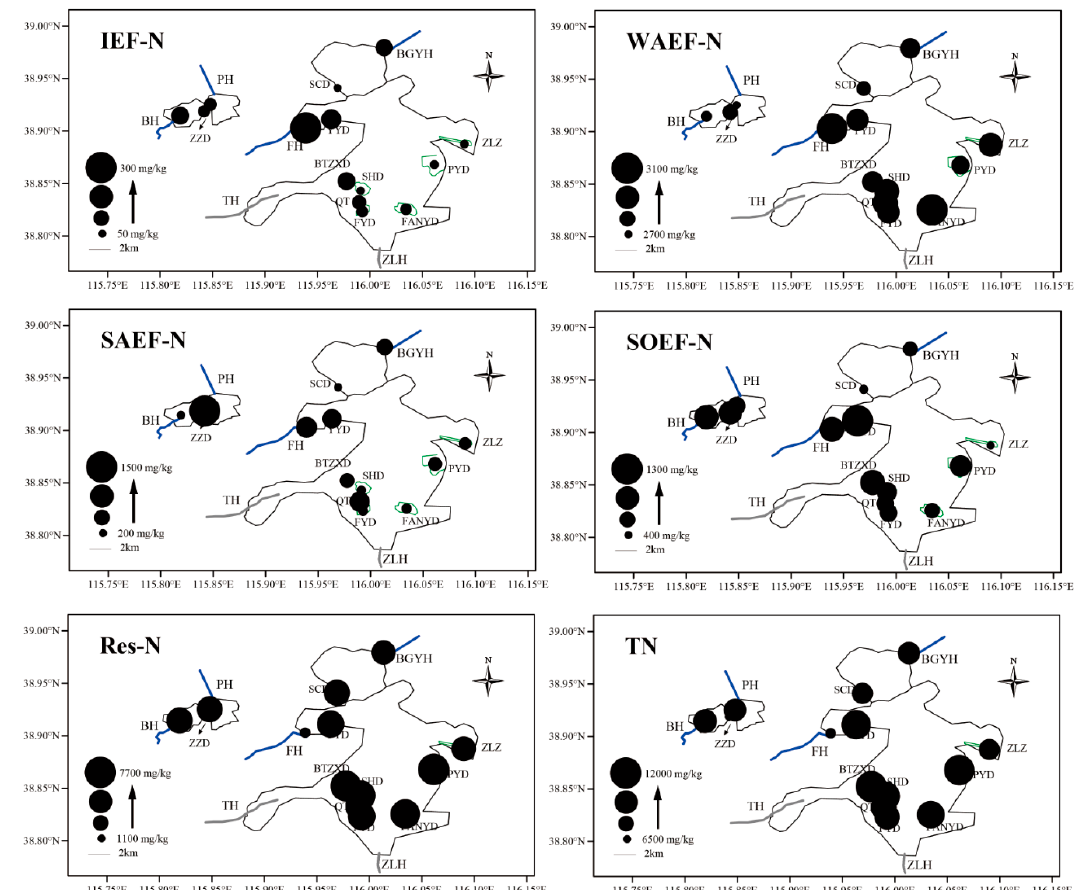
Figure 2. Spatial distribution for IEF-N, WAEF-N, SAEF-N, SOEF-N, Res-N and TN of sediment N in Baiyangdian Lake (the size of circle was proportional to the concentration of nitrogen).